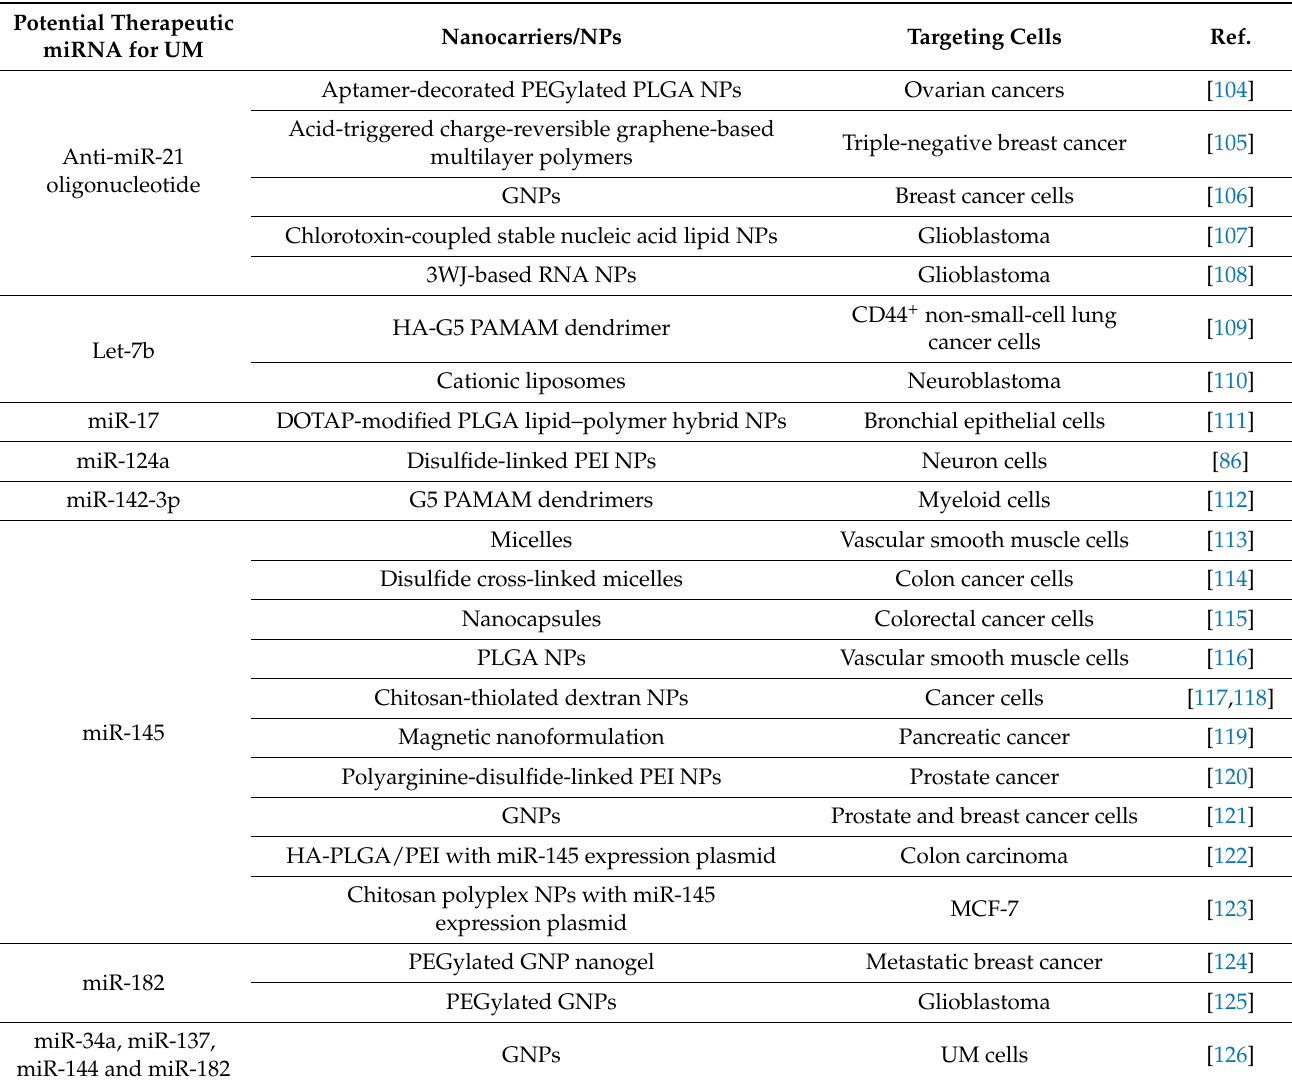
Table 2. List of nanocarriers/NPs for the delivery of potential therapeutic miRNAs for UM. Potential